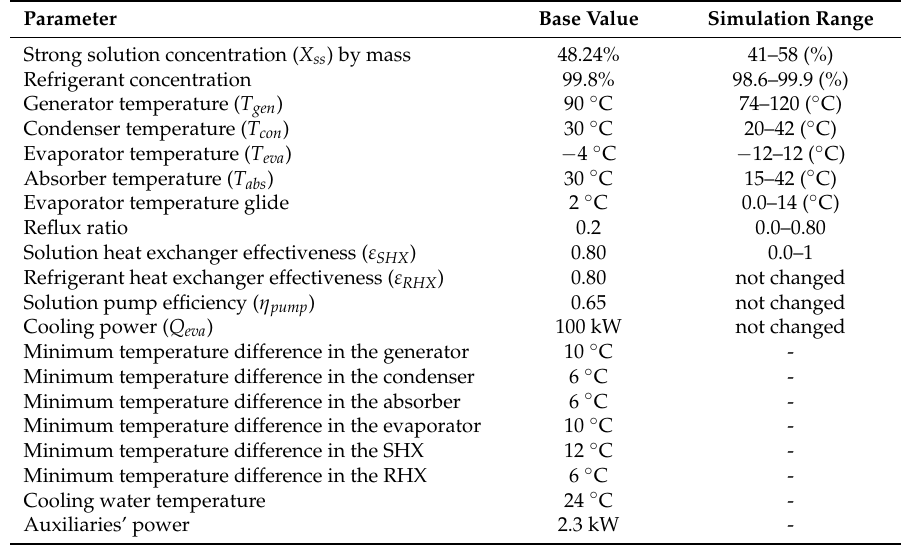
Table 3. Base values for system’s parameters and their simulation